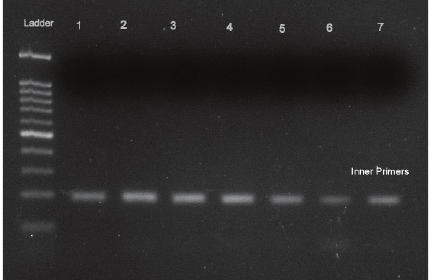
Figure 2: Nested PCR results with the inner primers yielded 194 bp DNA fragment in the positive cases of Cryptosporidium . Lane 1: Positive control. Lanes 2–7: Amplicons of positive